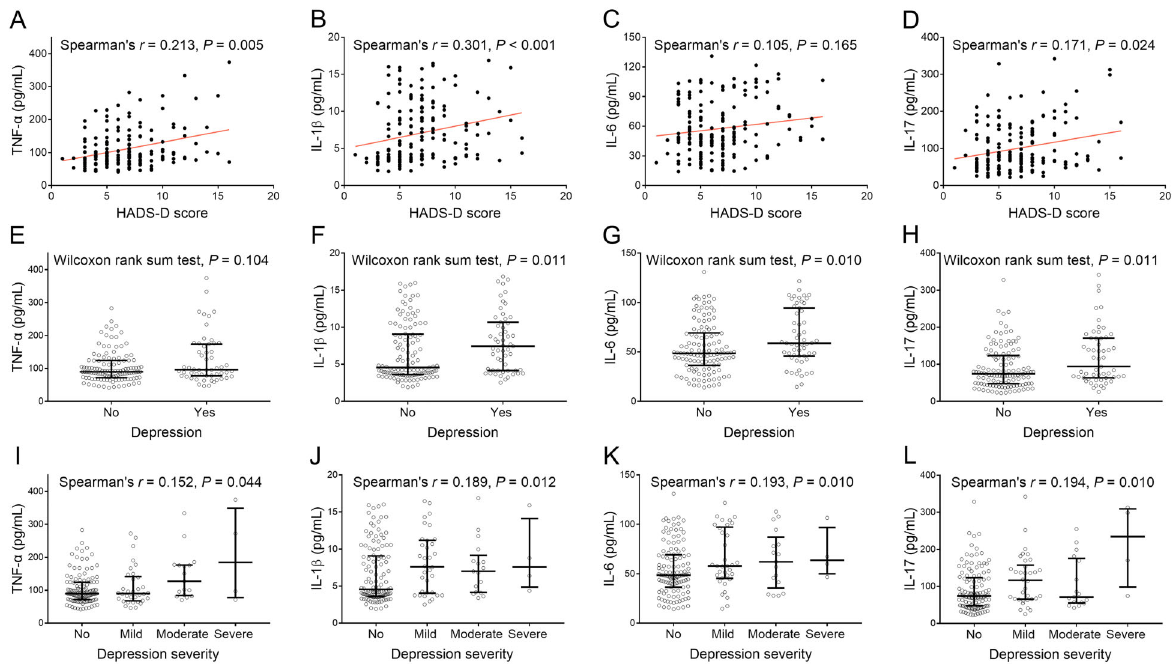
Figure 4. Common in fl ammatory cytokines were positively associated with depression in acute ischemic stroke patients. Correlation of TNF- a , IL-1 b , IL-6, and IL-17 with HADS-A ( A – D ), with depression occurrence ( E – H ), and with depression severity ( I – L ). Lines indicate median and IQR. TNF- a : tumor necrosis factor alpha; IL: interleukin; HADS-D: Hospital Anxiety and Depression Scale for depression.